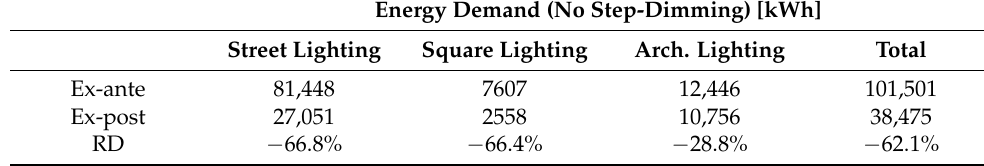
Table 9. Energy demand of the ex-ante and ex-post installations considering only the substitution of luminaires.